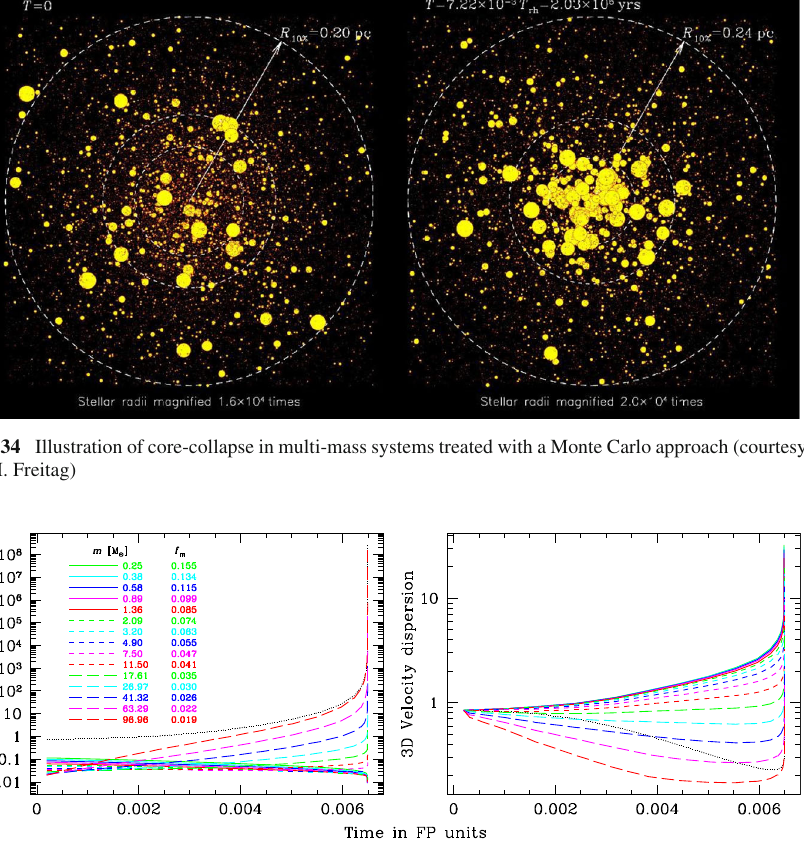
Fig. 35 Evolution of the central density and 3 D -velocity dispersion in a model with 15 components (see text for further